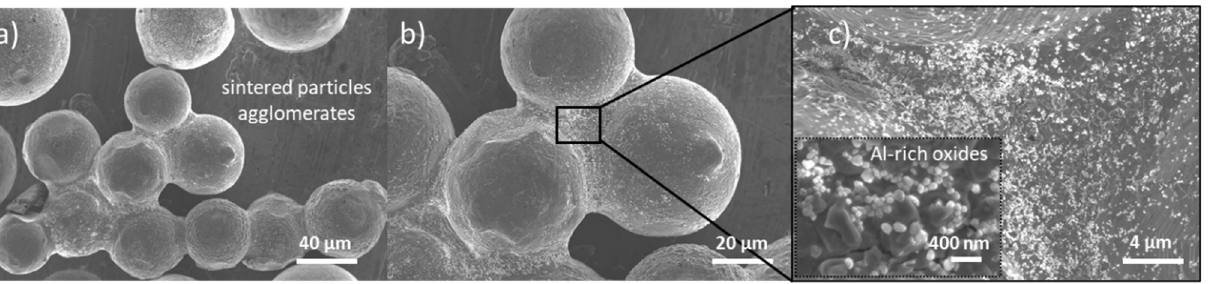
Figure 3. Oxidation of powder in the sintered cake: ( a ) agglomerate of particles found in reused powder, ( b ) interparticle necks formed during sintering and ( c ) Al-rich oxides observed at the in- terparticle necks.